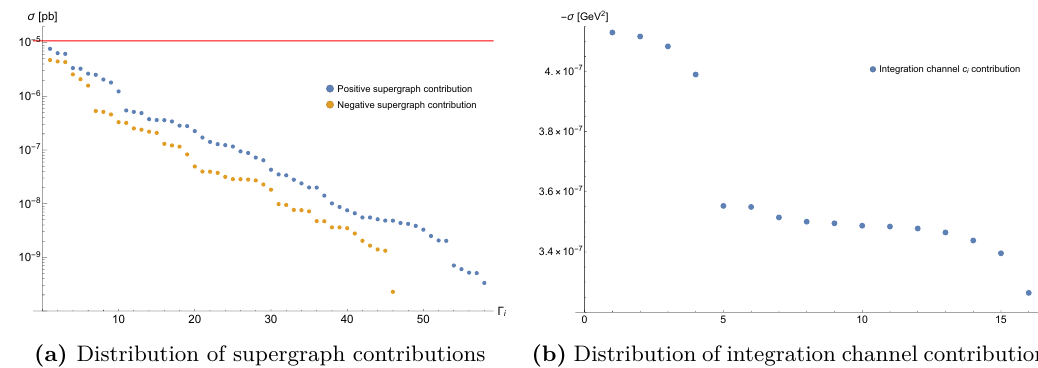
Figure 12. To the left, we show the distribution of the contributions to the LO cross section for the 104 distinct non-zero supergraphs for the processes e + e − → γ ? → t ¯ tggg and e + e − → γ ? → t ¯ tg Their sum, indicated by a red horizontal line, reproduces the total cross section of 1 . 071 · 10 − 5 [pb] obtained from MadGraph5_aMC@NLO with To the right, we show the distribution of the negative of the contributions of each of the 16 inte- gration channels for the 3-loop scalar supergraph a.3) of table 2, summing up to the forcer result of − 5 . 754 · 10 − 6 [GeV 2